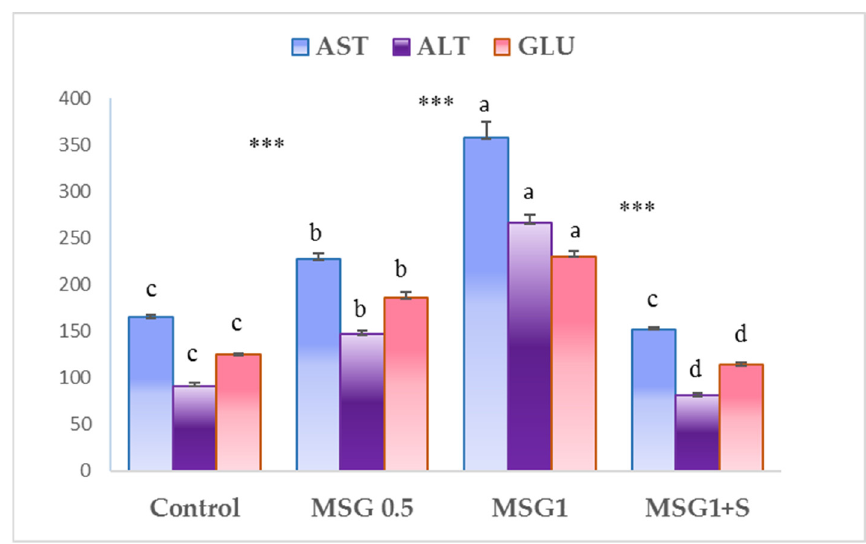
Figure 2. Average values of blood biochemical parameters such as AST, ALT, and GLU for each experimental group. Mean values ± standard deviation ( n = 5). Statistically significant differences among experimental groups for each biochemical parameter obtained with the Tukey HSD test are indicated by different lower-case letters. ***: significant at the 0.001 probability level.